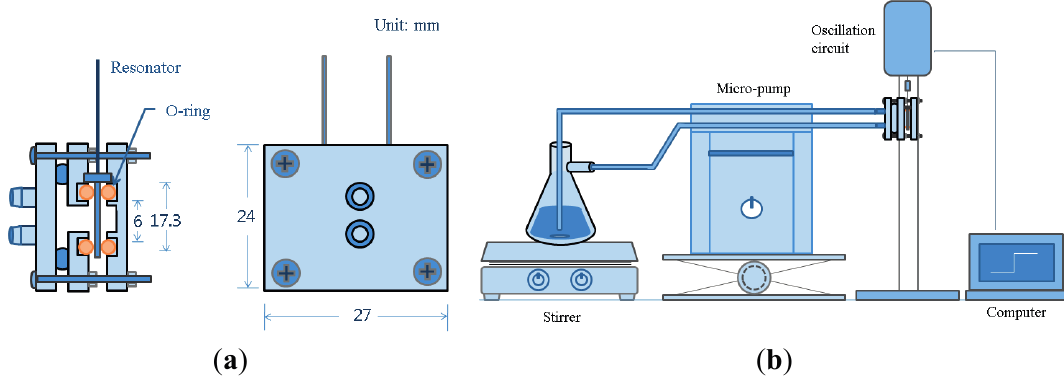
Figure 2. Schematic diagram of the cell module ( a ) Cell configuration; ( b ) Experimental setup for water content